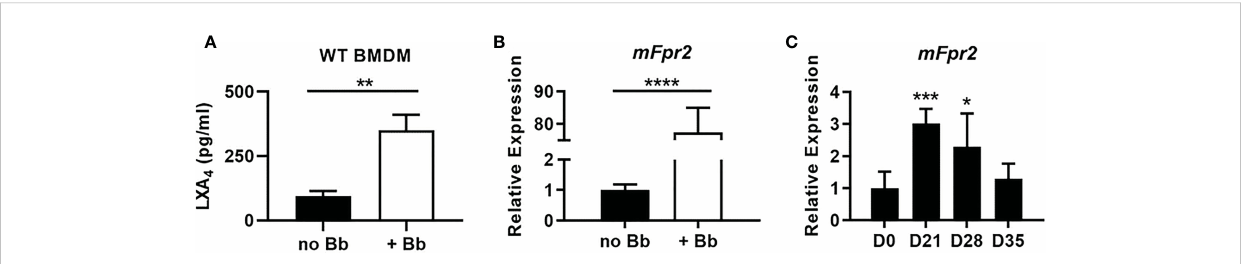
FIGURE 5 LXA 4 :mFpr2 signaling axis components are upregulated in response to B. burgdorferi . (A) LXA 4 production by WT BMDMs after 2hr incubation with control (no Bb ) or Bb (MOI 10). (B) mFpr2 mRNA expression by RT-qPCR after 24hr culture +/- Bb , normalized to Gapdh and relative to expression in unstimulated (no Bb ) BMDM. (C) mFpr2 mRNA by RT-qPCR from WT ankle joints during mLA, normalized to Nid1 and relative to D0 levels. (A, B) n=3/treatment, assayed in duplicate, *p<0.05, **p<0.01, ***p<0.001, ****p<0.0001 by t-test. (C) n=7-10/timepoint, one-way ANOVA with Dunnett ’ s posttest, compared to D0.